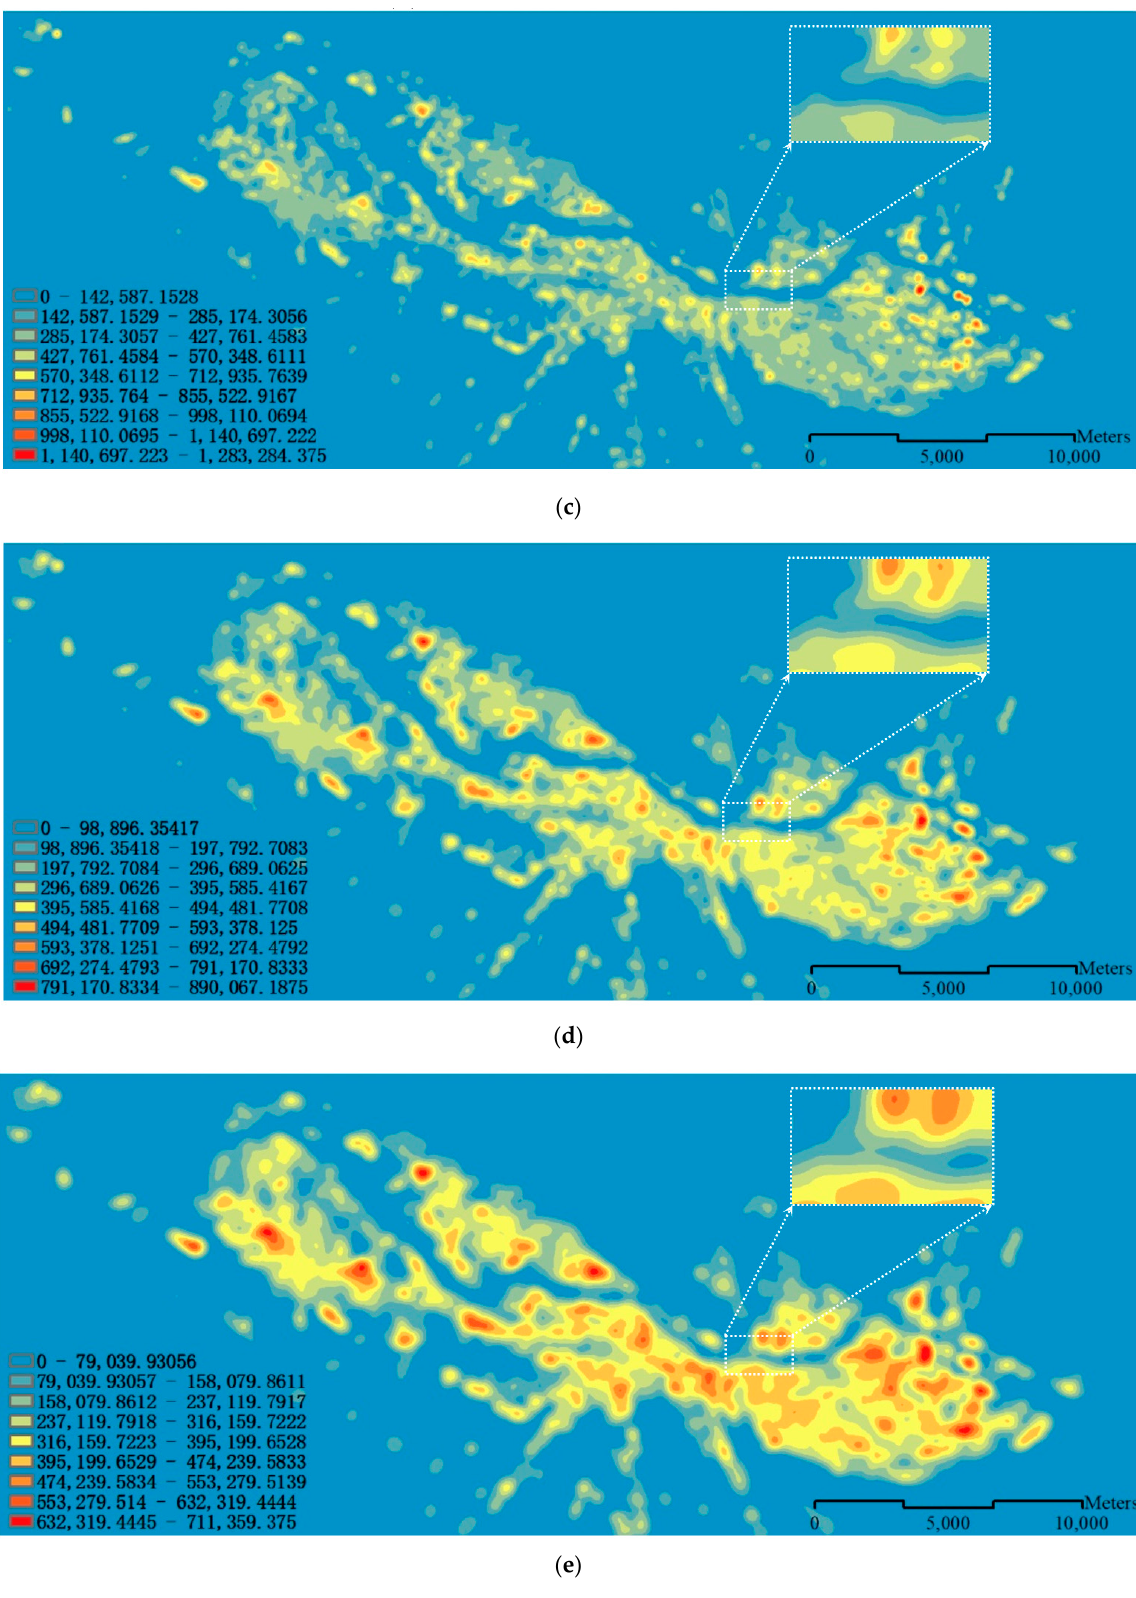
Figure 9. Urban hot spots detected by KDE with different thresholds but with the same refined cell size (10 m): ( a ) is the result when the search radius is 150 m; ( b ) is the result when the search radius is 200 m; ( c ) is the result when the search radius is 300 m; ( d ) is the result when the search radius is 400 m; and ( e ) is the result when the search radius is 500